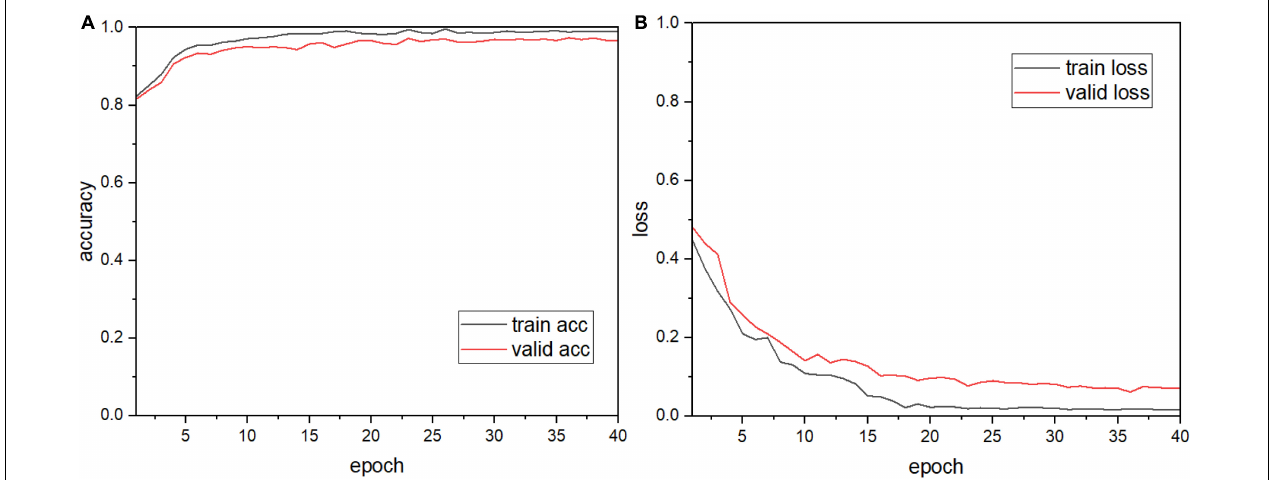
FIGURE 6 | Our model graph: (A) accuracy and (B)